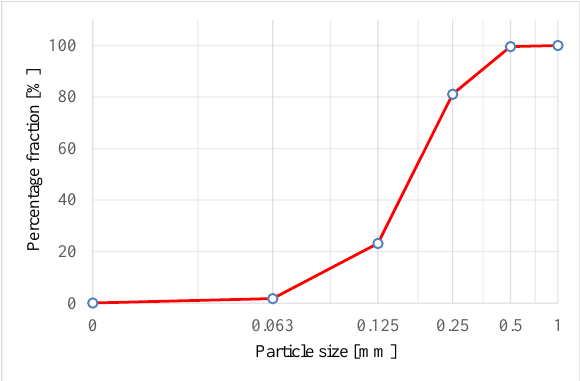
Figure 1: Sand grain size